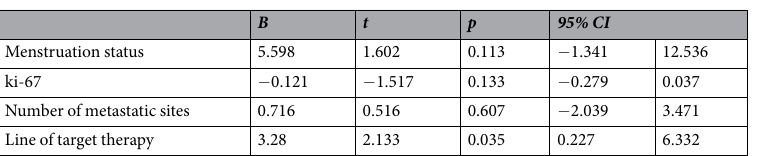
Table 3. Multivariate analyses of the associations between the fractions of trunk mutations and clinical